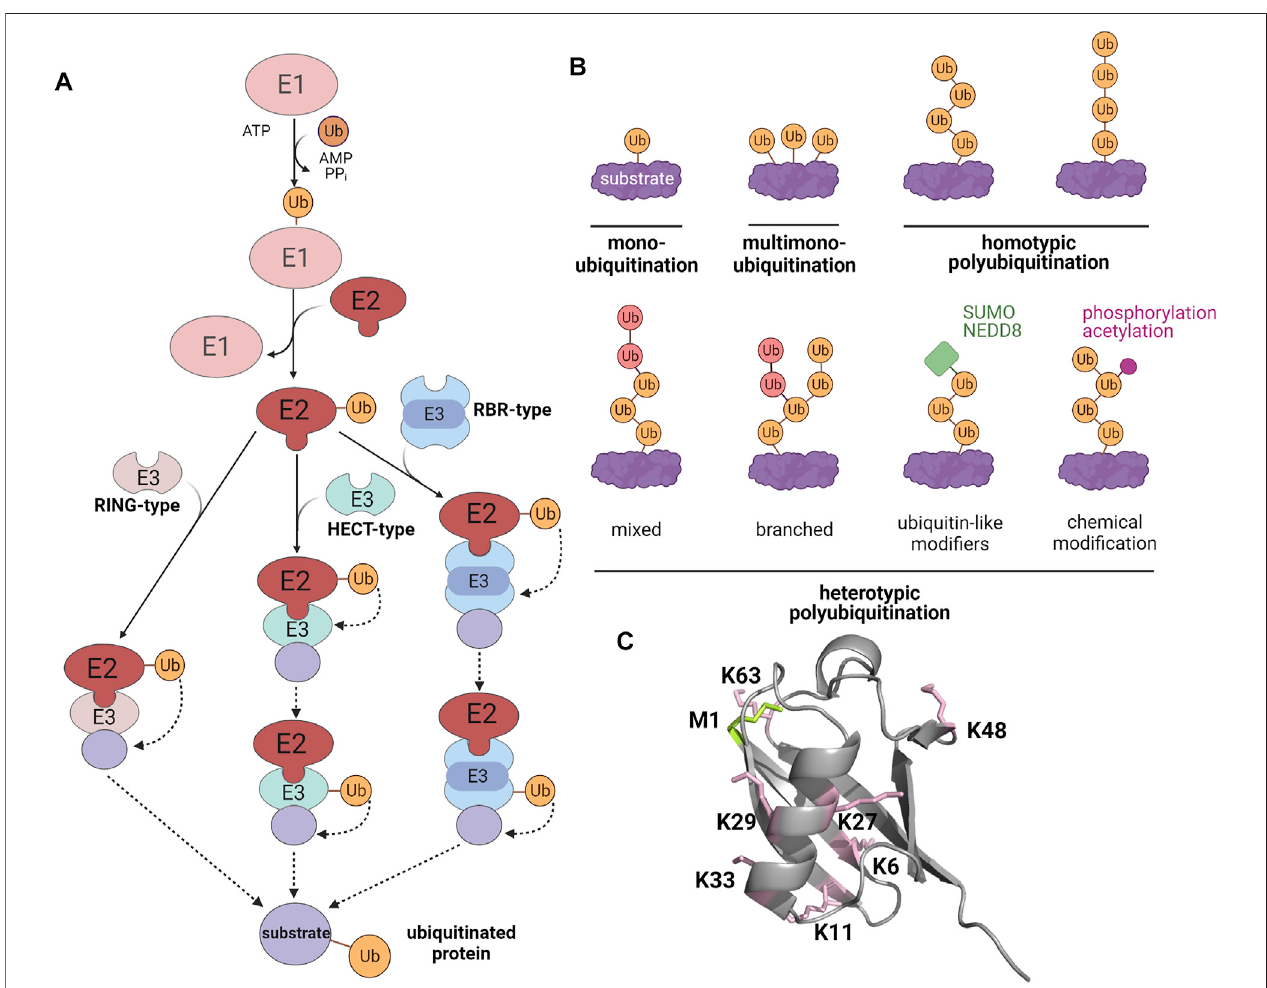
FIGURE1| The modi fi cation ofsubstrate proteins byubiquitin. (A) Enzymatic cascade ofubiquitination. E1,ubiquitin-activating enzyme;E2,ubiquitin-conjugating enzyme; E3, ubiquitin ligase. (B) Different types of ubiquitination (C) X-ray crystallographic structure of ubiquitin (PDB: 1UBQ). Lysines are highlighted in pink and the methionine at the N-terminus is shown in green. Created with